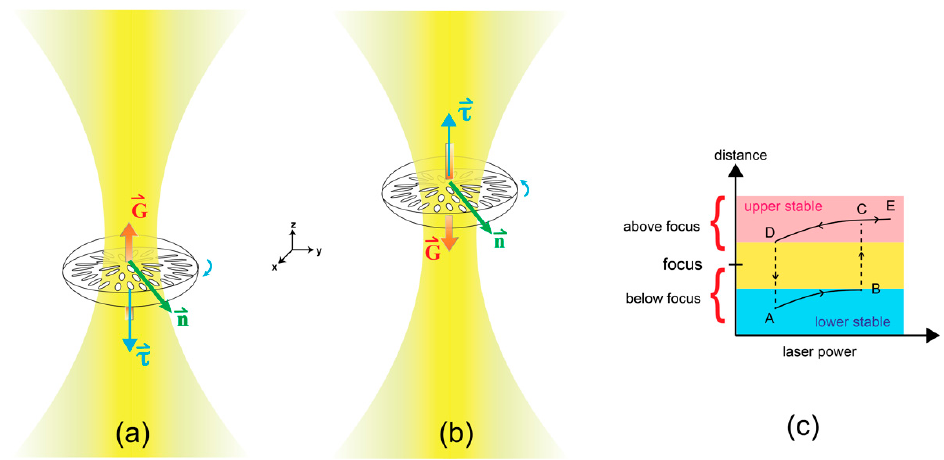
Figure 6. Schematic illustration of the droplet position at ( a ) low power and ( b ) higher power of a laser when slowly increasing the power of the trapping laser. G represents direction of temperature gradient due to laser intensity. The temperature gradient points toward the laser focus. n is the direction of average molecular directors of the distorted radial droplet. τ is torque direction of the droplet from n × n × G , which resulted in clockwise rotation in ( a ) and counterclockwise rotation in ( b ). ( c ) Particle position with laser power illustrated roughly the observation of Ashkin’s experiment in optical levitation [15].